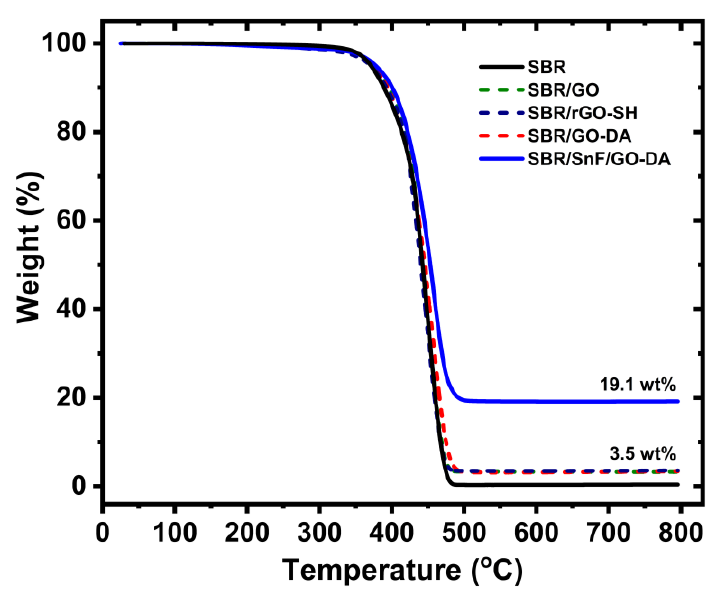
Figure 5. TGA measurements of the styrene–butadiene rubber (SBR) composites. The silica and GO weight percent loadings according to the plateau values are in good agreement with the filler loadings of the composites which are 15 and 4 wt.%, respectively.